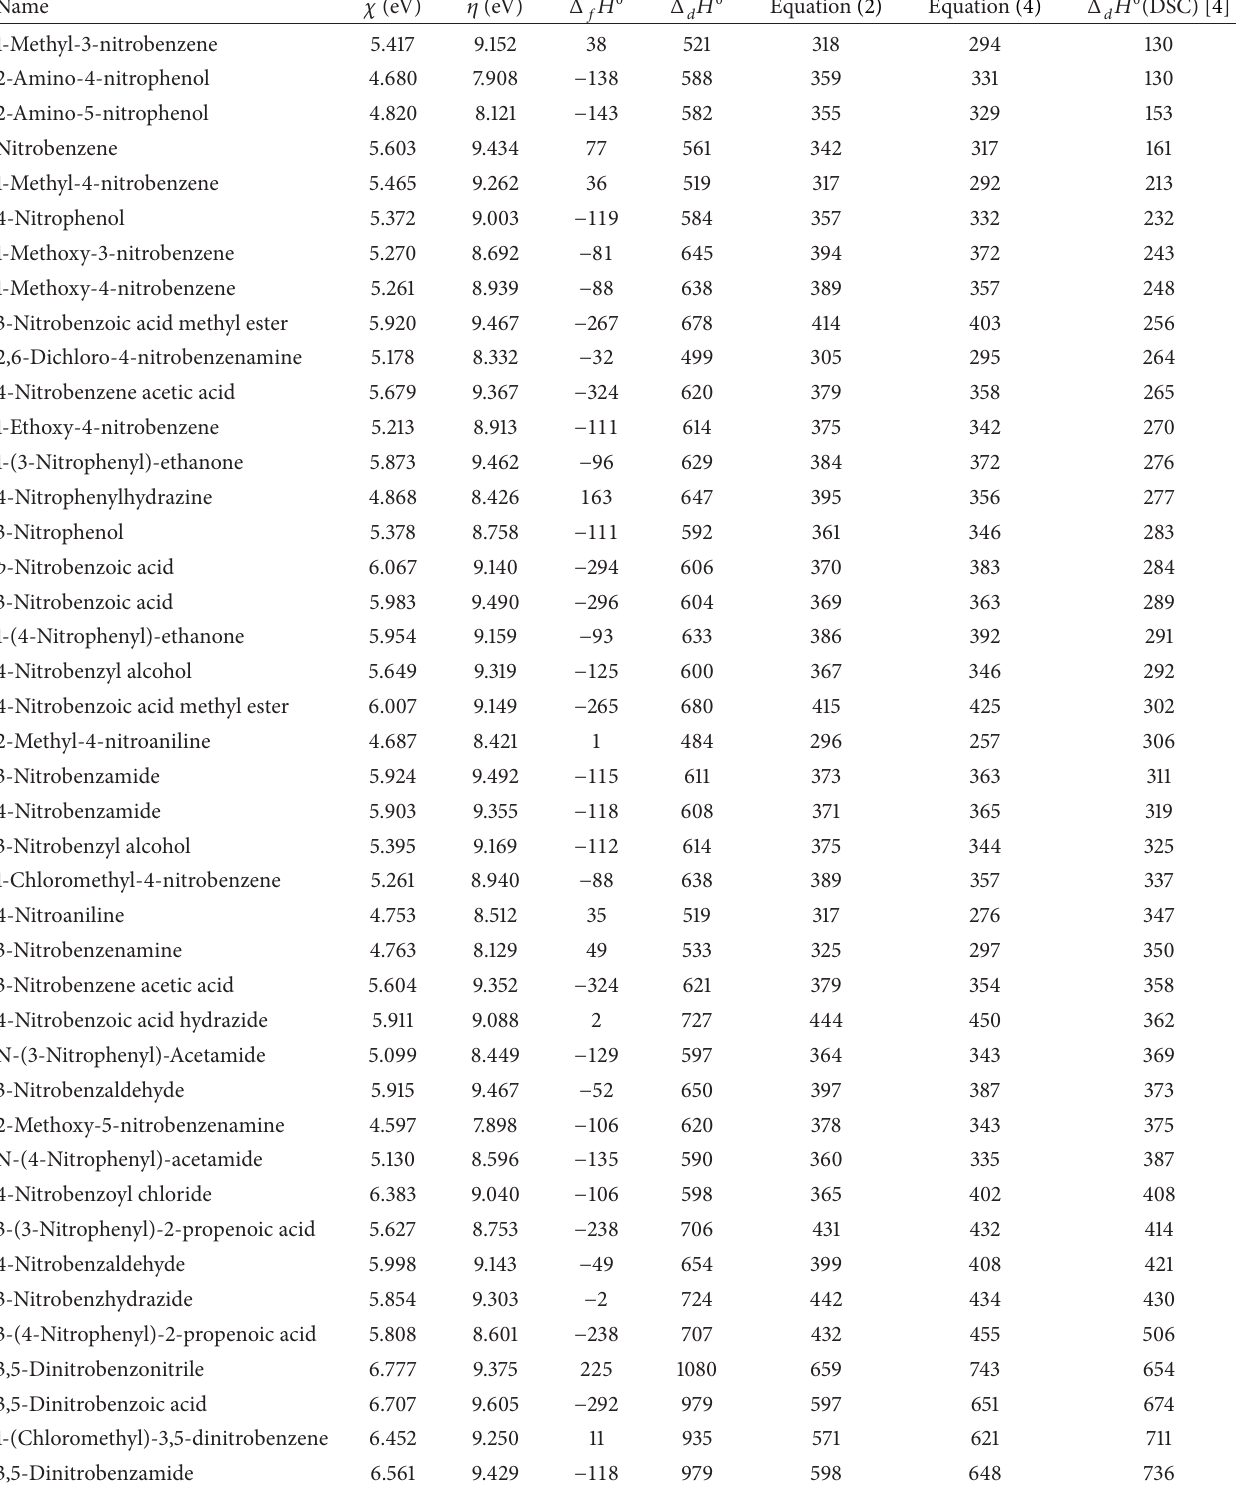
Table 3: The same data as in Table 2 for the 42 nonortho compounds studied in pin-hole sample